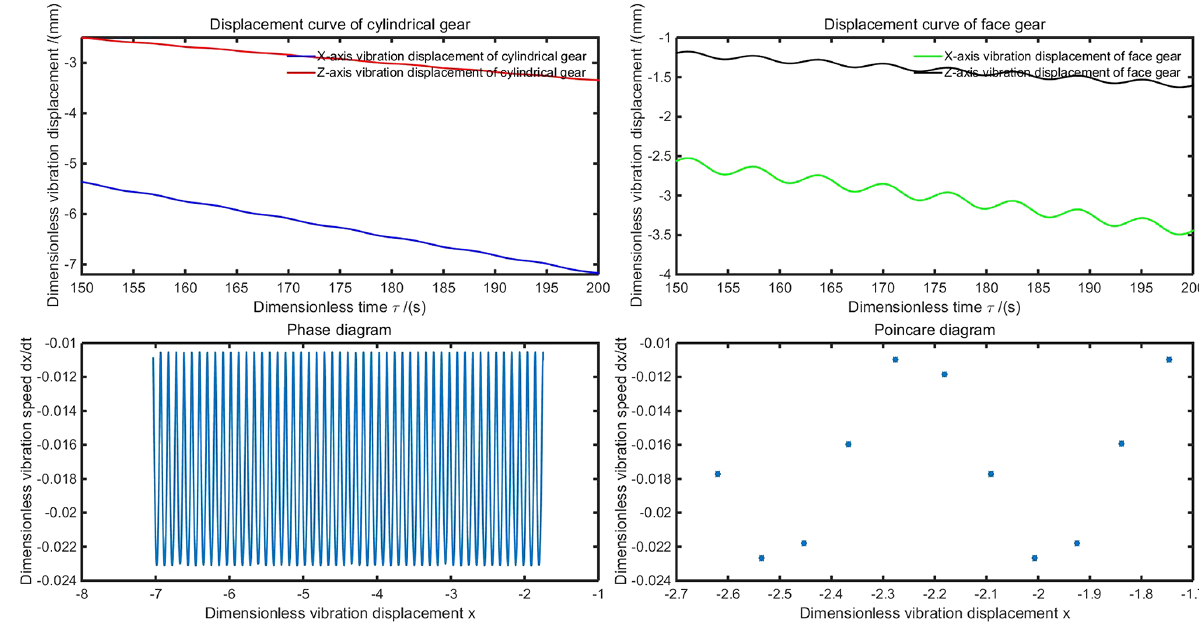
Figure 9. Displacement, phase, and Poincare diagrams of friction coefficient 1.